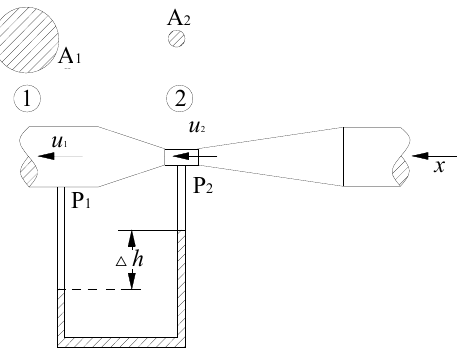
Figure 5. A schematic diagram of the venturi tube.